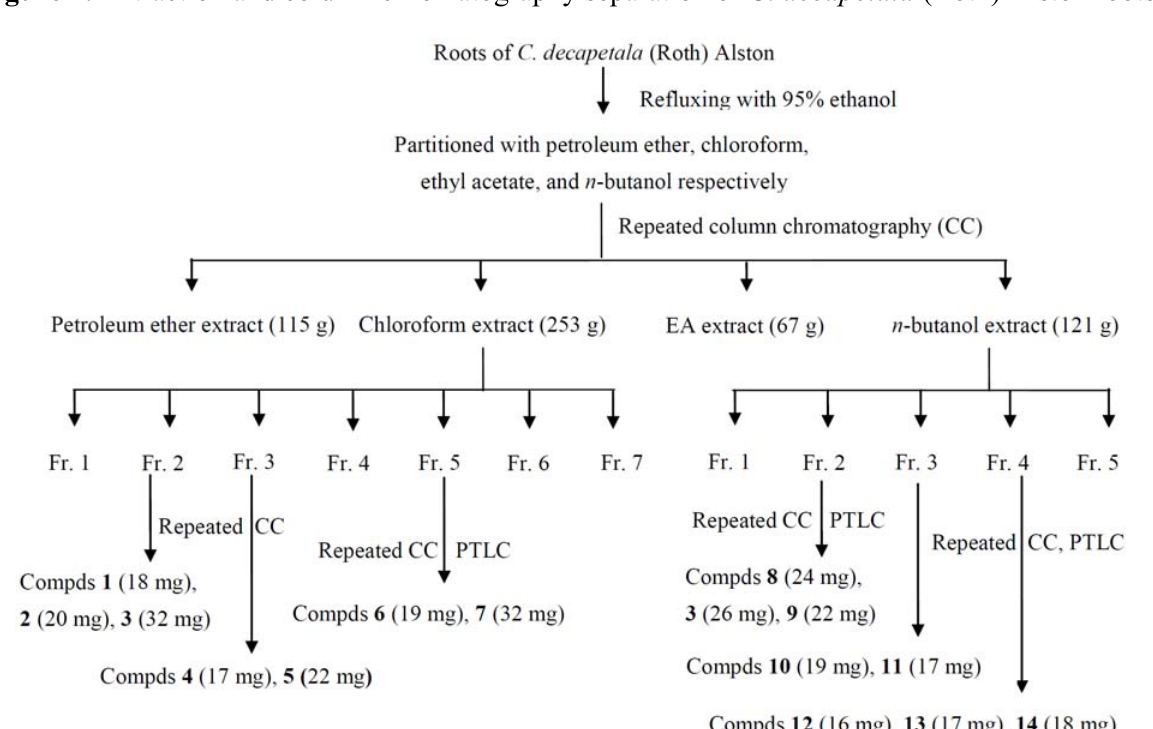
Figure 2. Extraction and column chromatography separation of C. decapetala (Roth) Alston